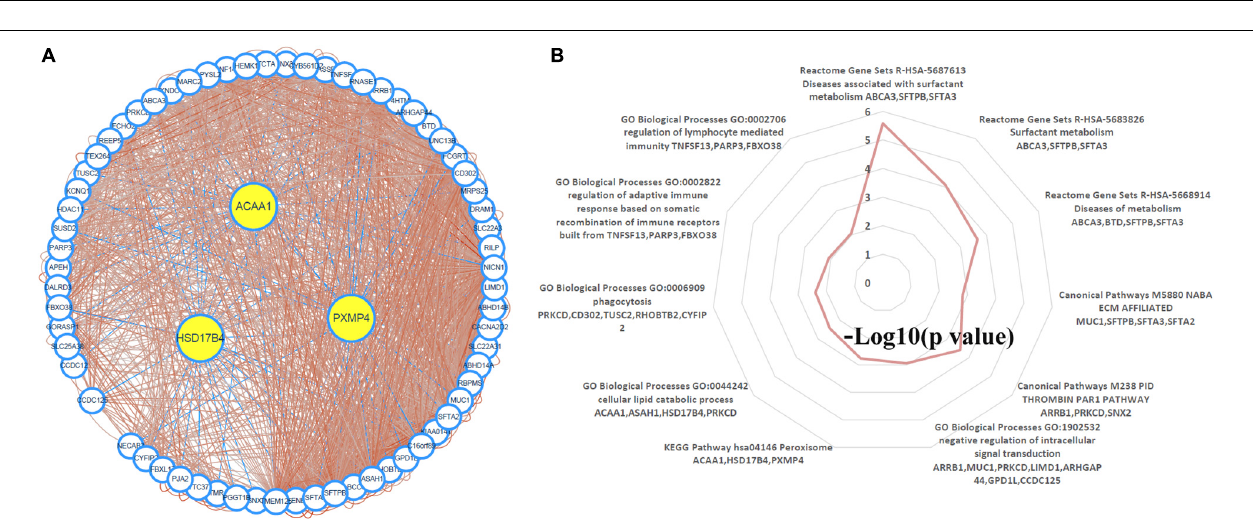
FIGURE 8 | Construction and analysis of the NSCLC specific co-expression network of HSD17B4, ACAA1, and PXMP4. (A) NSCLC specific co-expression network of HSD17B4, ACAA1, and PXMP4. (B) Functional enrichments of the genes in the network. NSCLC, non-small cell lung cancer.